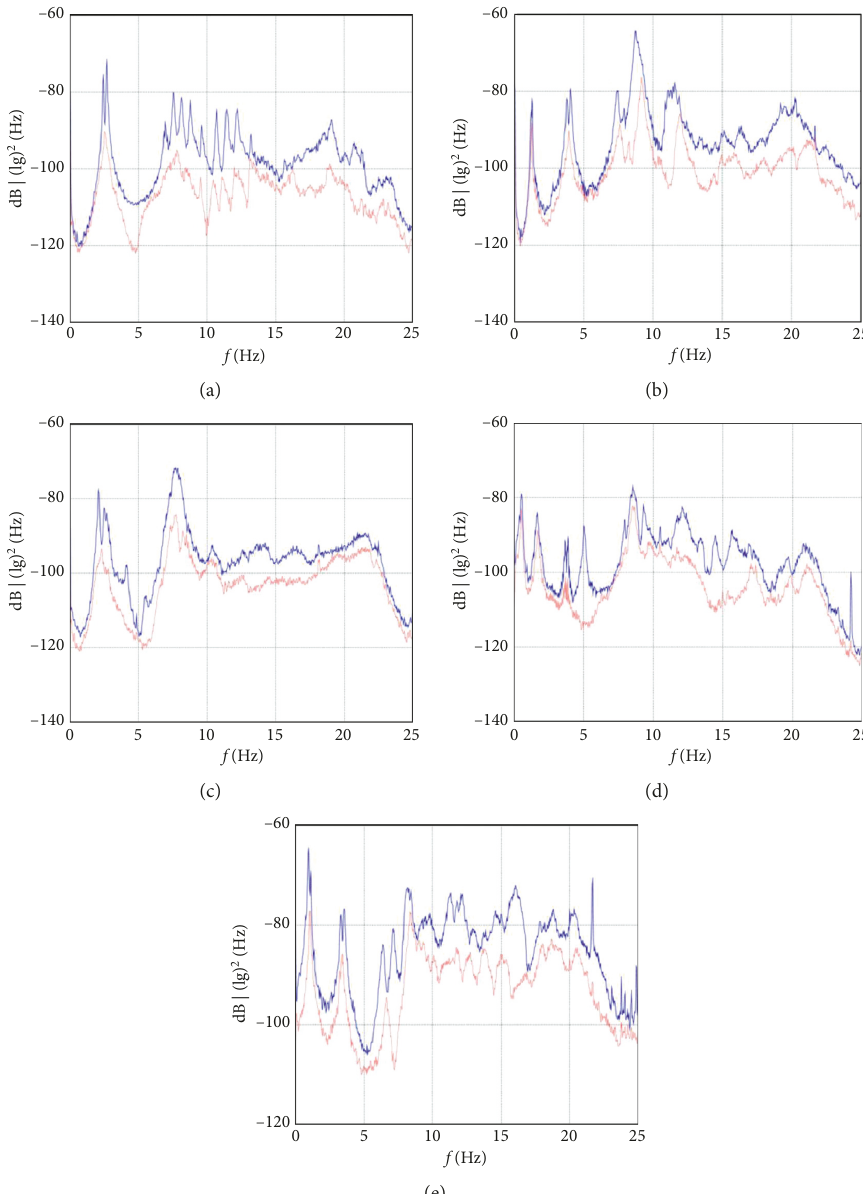
Figure 4: The singular values of the spectral densities of all of the test setups: (a) Tes¸vikiye Mosque minaret; (b) G¨ull¨uk Mosque minaret; (c) A˘ga Mosque minaret; (d) Ali Kuzu Mosque minaret; (e) Fethiye Mosque